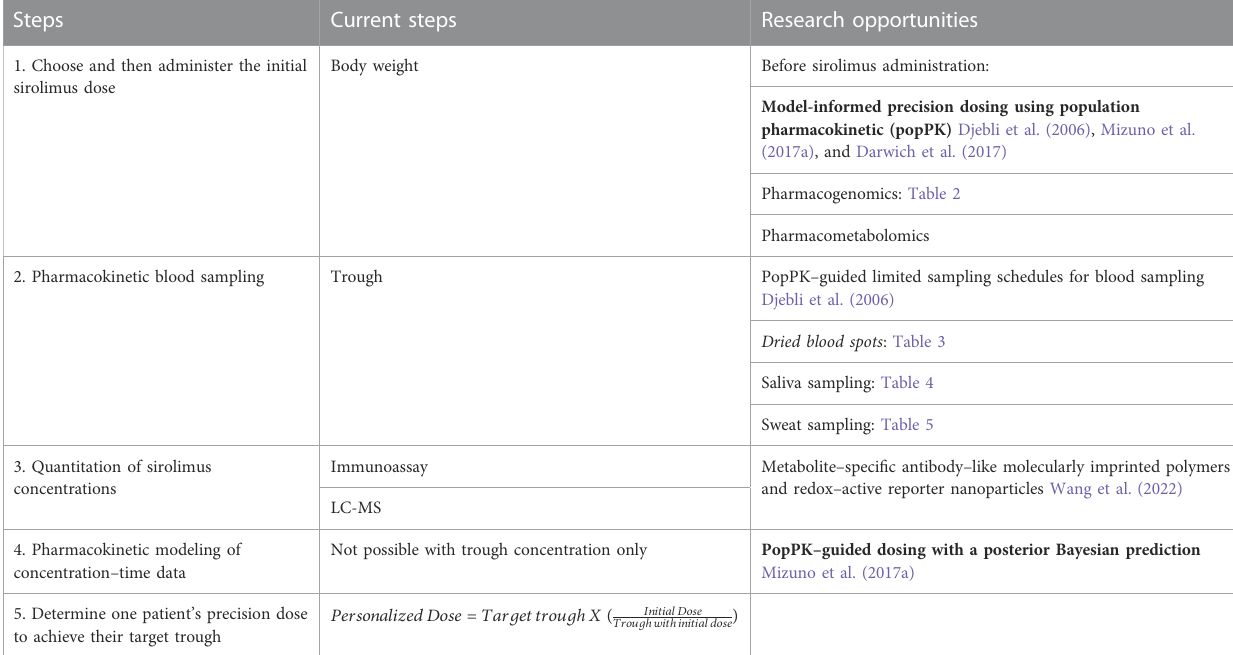
TABLE 1 Steps of and research about precision sirolimus dosing: TDM of sirolimus dosing the initial ( fi rst) dose to achieve the target trough. The tools in the bold font should be implemented, and those in the italicized font are not recommended for clinical use. Steps Current